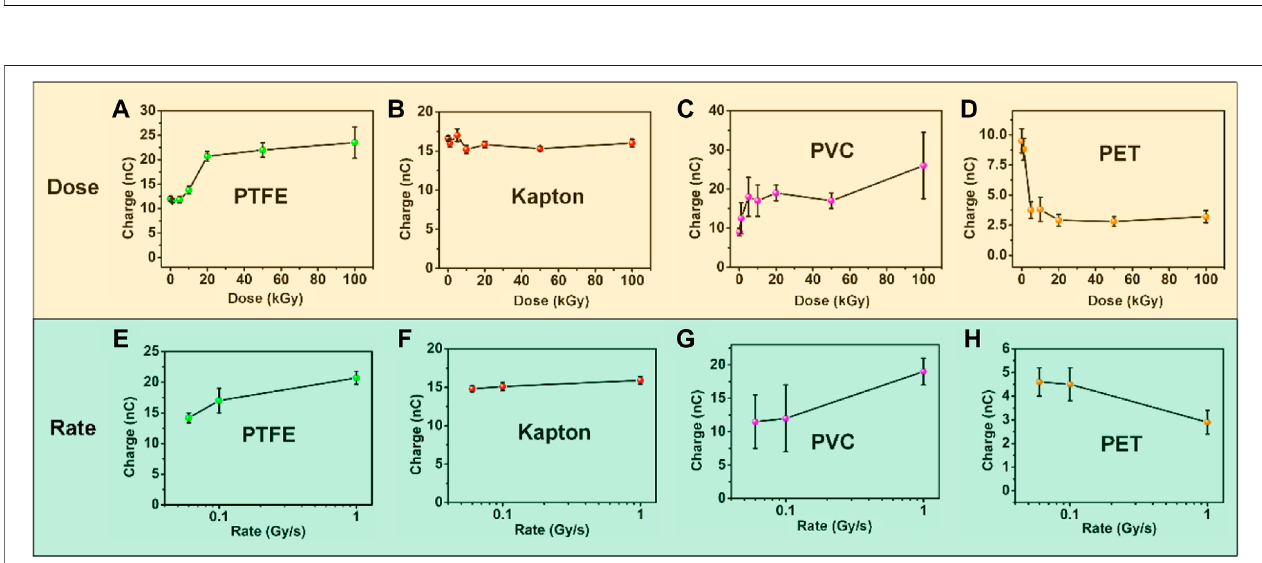
FIGURE 2 | Output charges of four polymers under various doses at a certain radiation rate of 1 Gy/s: (A) PTFE; (B) Kapton; (C) PVC; (D) PET. As the radiation dose goes up, the output charge of PTFE gets larger. Kapton kept stable. PVC shows a similar behavior as PTFE, whereas PET shows an opposite trend. Output under various rates at a fi xed dose of 20 kGy: (E) PTFE; (F) Kapton; (G) PVC; (H) PET. Kapton still shows as very stable. PTFE and PVC ’ s output becomes higher, whereas PET ’ s becomes lower, as the radiation rate increases.